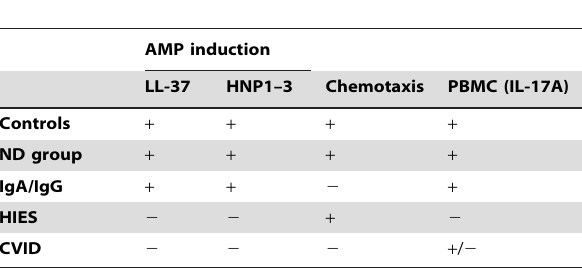
Table 2. Summary of results obtained in the